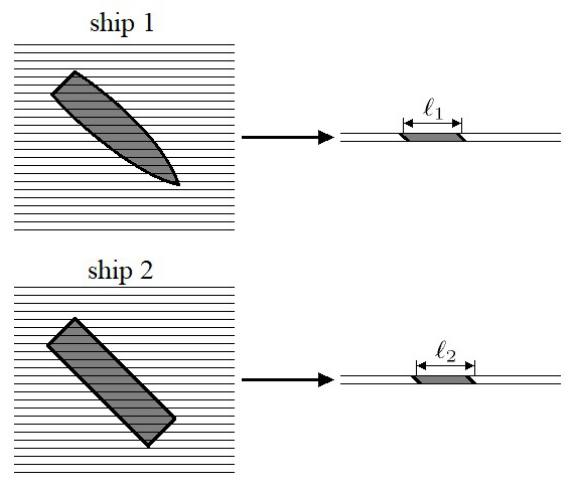
Figure 18. Comparison of ship footprint.